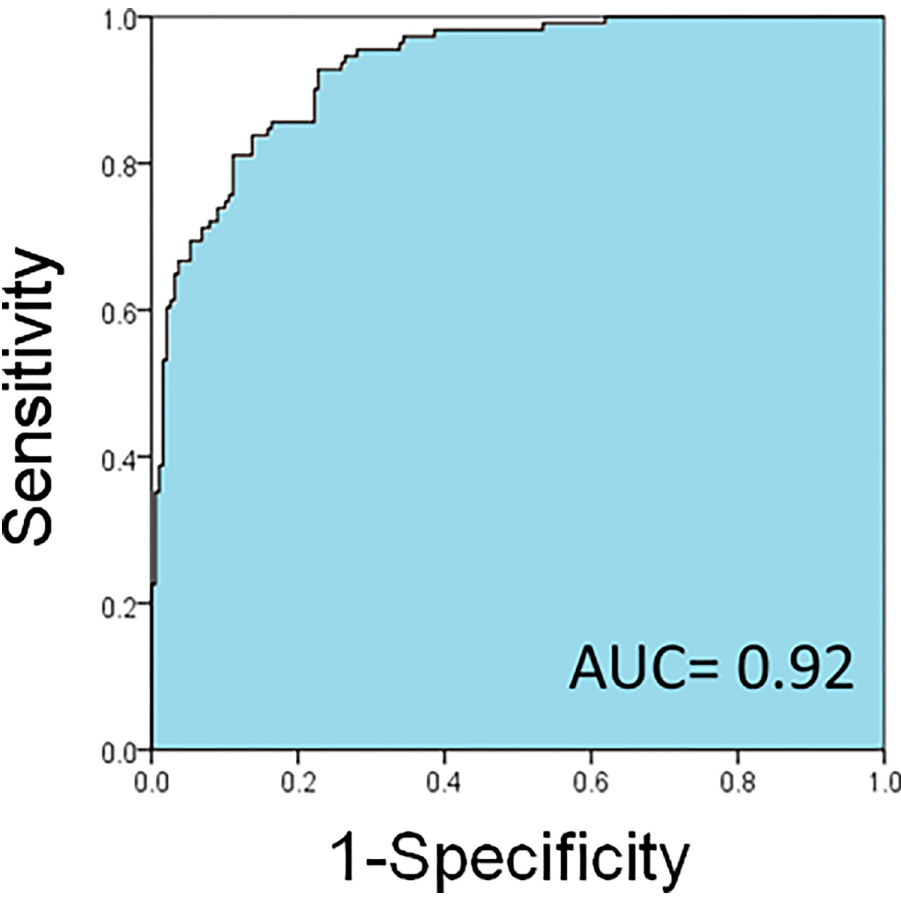
Fig 5. The ROC curve for the classification of normal and abnormal images by mean Amb-I of each layer of the retina, classified by AUC = 0.92.